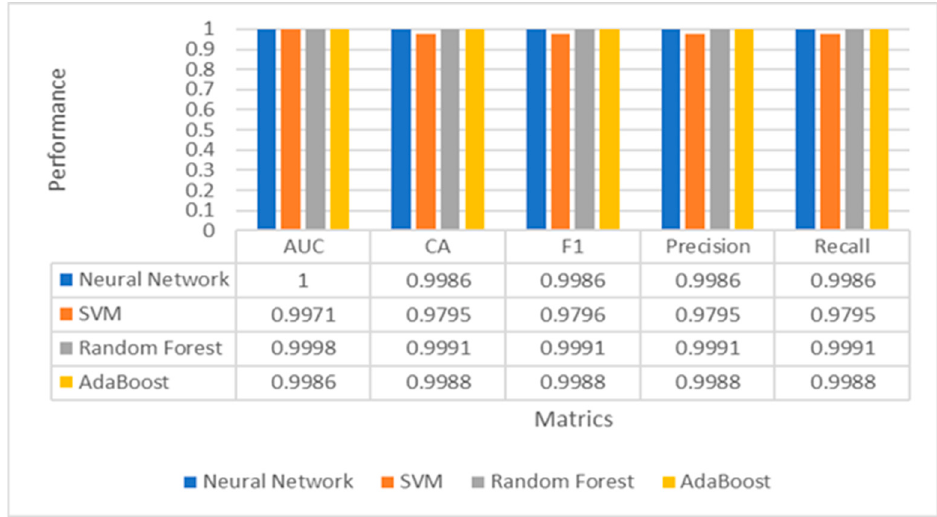
Figure 10. Performance evaluation of multiple classifiers for password strength estimation.